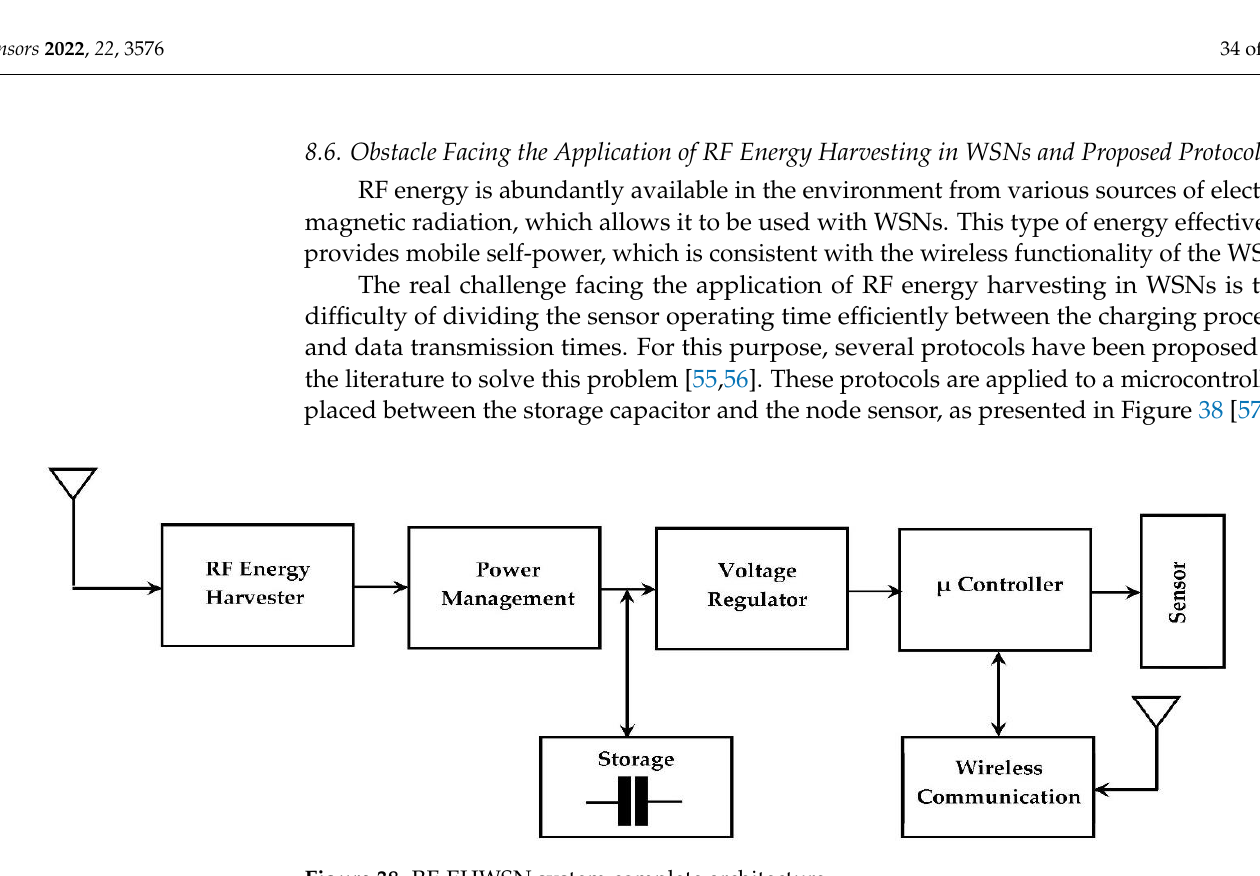
Figure 38. RF-EHWSN system complete architecture